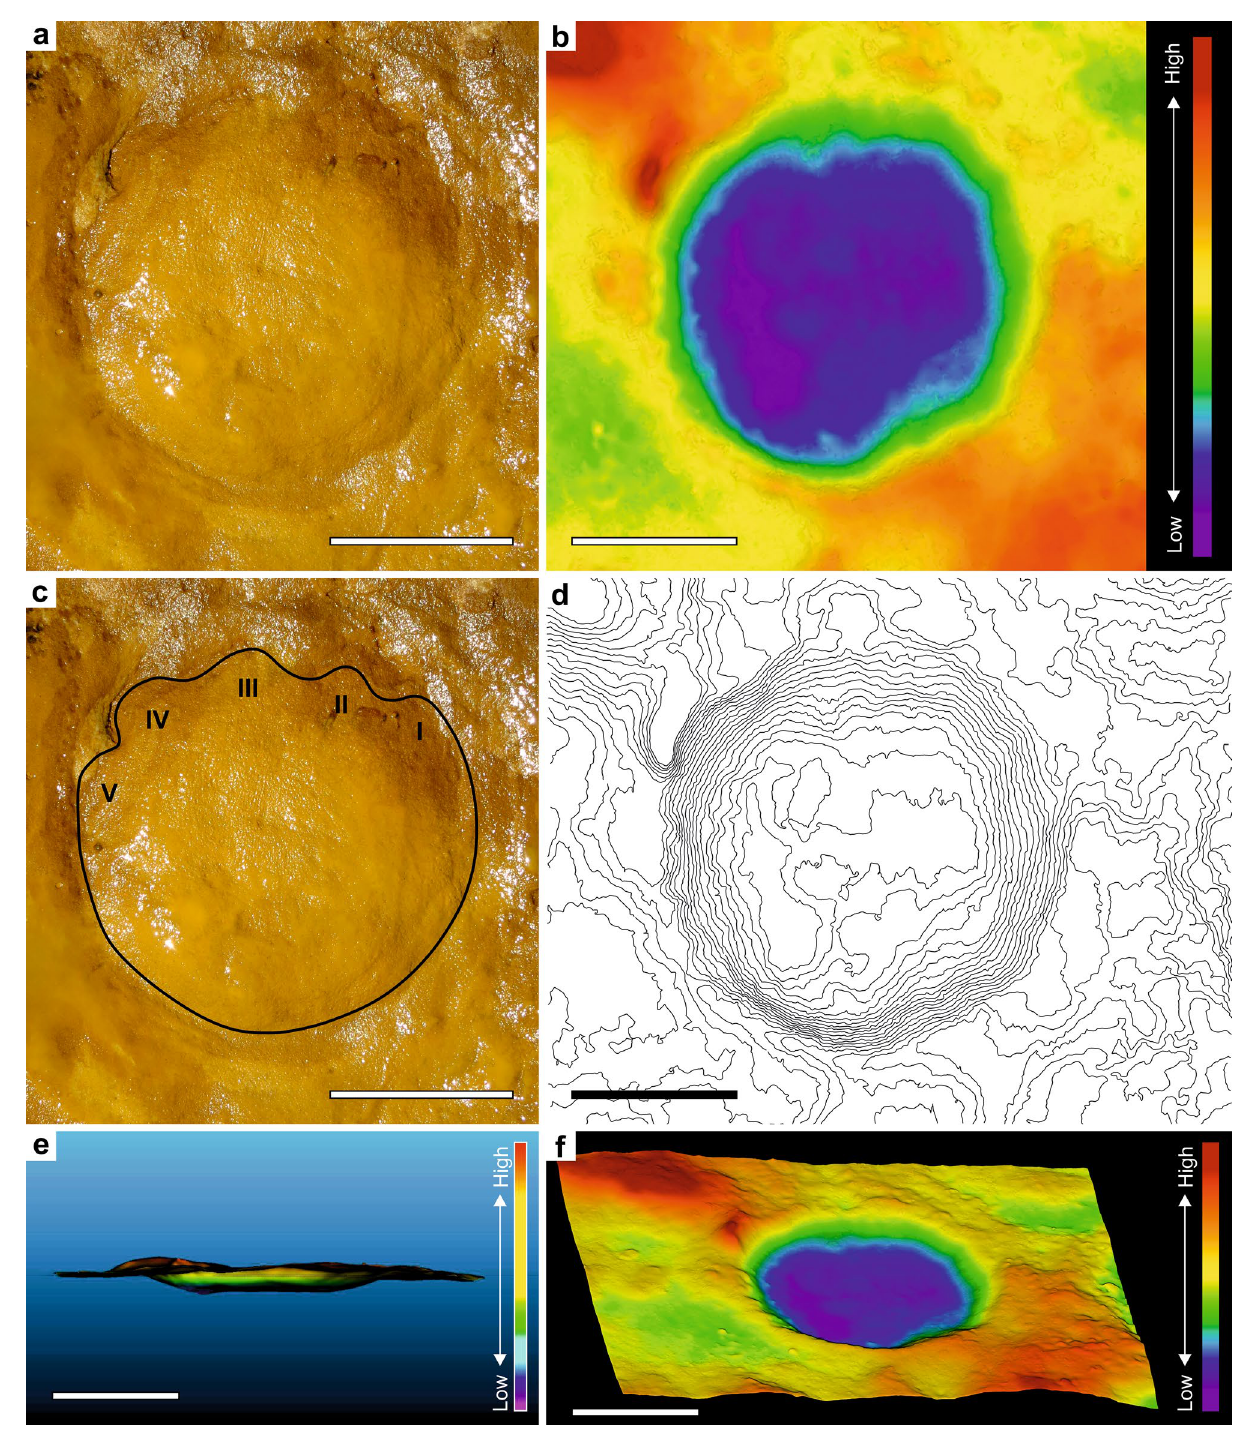
Figure 3. Photograph, outline, high-resolution 3D and false-coloured 3D images of the PAT/MTS/0011a track representing the best preserved manus of a juvenile-sized Proboscipeda track. ( a ) and ( c ) From the photograph and high-resolution images, five toe impressions in the anterior part of the rounded track are clear (especially toes I–IV). ( b ) and ( f ) The false coloured images in orthogonal ( b ) and oblique angle views ( f ) highlight the deepening of the track fore- and outwards, thus revealing a peak pressure pattern typical of left forefoot (toes III–IV), as well as a possible ejecta mound in front of the track. The poorly evident and narrow expulsion rim developed around the track is the result of the high cohesiveness and plasticity of the clayey fine-sand substrate. ( d ) Contour map supporting previous interpretation. ( e ) The cross-section of the track details the anterior migration of the foot pressure during its rotation, creating a peak pressure in the foot-off event that is represented in the deepest part of the track. Scale bars are 10